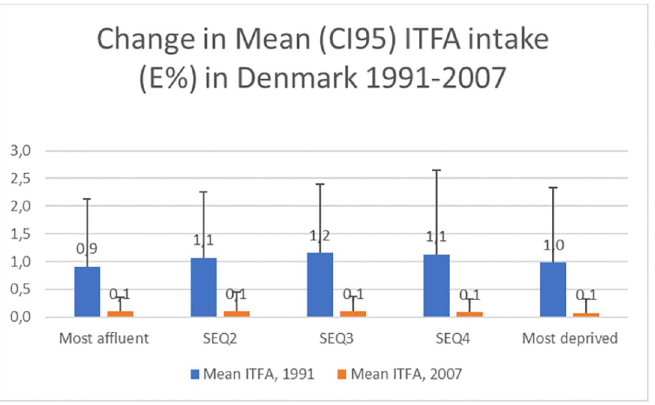
Fig 1. Trends in mean ITFA intake (%E) in Denmark 1991–2007 divided into socio-economic quintiles. Top lines indicate 95% CIs.